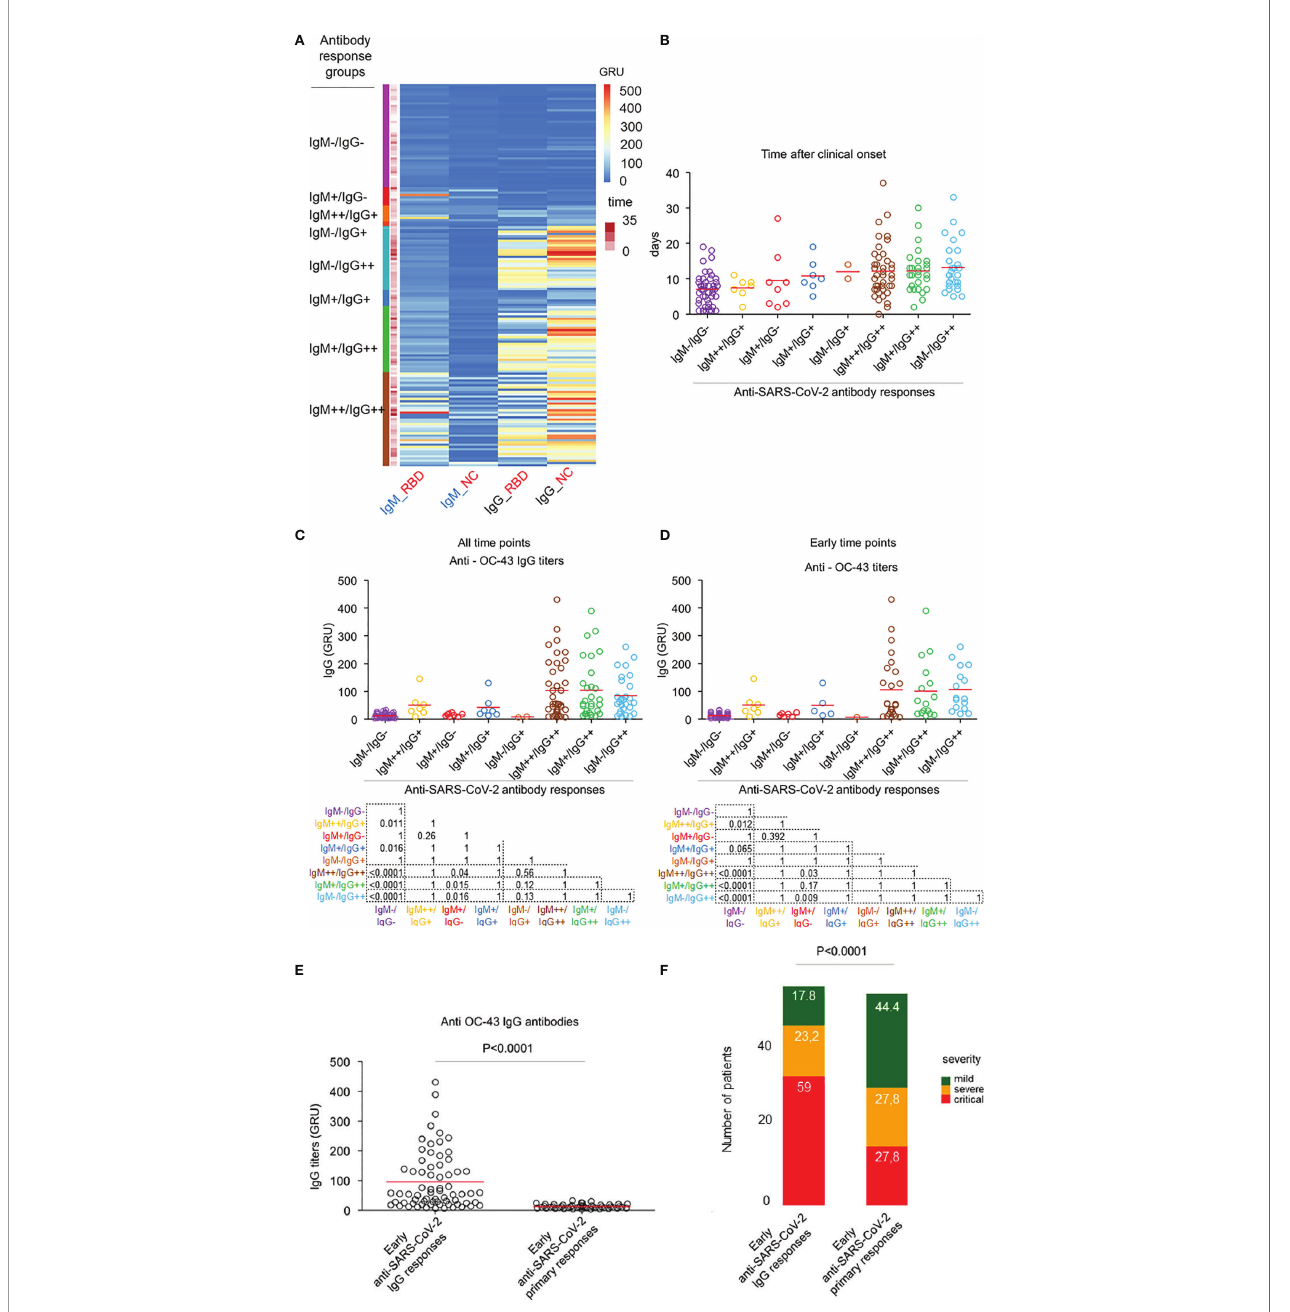
FIGURE 3 | HCoV-induced cross-reactive anti-SARS-CoV-2 antibodies do not protect against COVID-19. (A) Heatmap representation of the IgG and IgM titres for NC and RBD SARS-CoV-2 coronaviruses; colors refer to z-score values. Patients were labelled according to their corresponding IgG/IgM subgroup. (B) Dot plot representation of the temporal distribution of the 8 identi fi ed subgroups of patients; mean time levels are represented in red circles. Dot red line is set at day 12. Sera drawn before or at day 12 are de fi ned as early, while those drawn after are de fi ned as late. (C) Dot plot representation of the anti-HCoV-OC-43 IgG antibody responses across all the IgG/IgM subgroups, which are colour-coded. Mean comparison was computed using the Wilcoxon test. (D) Dot plot representation of the anti-HCoV-OC-43 (right) IgG antibody across all the IgG/IgM subgroups which are colour-coded with the time points selected within 12 days after clinical onset. Mean comparison using Wilcoxon test was computed between IgM ++ /IgG ++ and IgM + /IgG - . (E) Dot plot representation of the anti-HCoV-OC-43 IgG responses by early (sera drawn with 12 days after clinical onset) anti-SARS-CoV-2 IgG and early primary response groups. Mean comparison using nonparametric Mann-Whitney U test was performed. (F) Bar plot representation of the distribution of severity patients across the early IgG responses (n=56) and early primary (n=54) subgroups. All sera were drawn within 12 days after fi rst symptoms. Frequencies of mild, severe and critical cases in each subgroup are indicated in each bar plot. Comparison of the proportions of severity subgroups between the early IgG response and early primary subgroups was made using the Chi-square